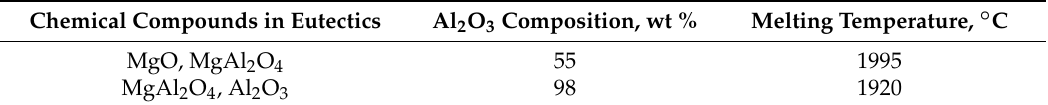
Table 2. Eutectic melting temperatures in the MgO–Al 2 O 3 system. Chemical Compounds in